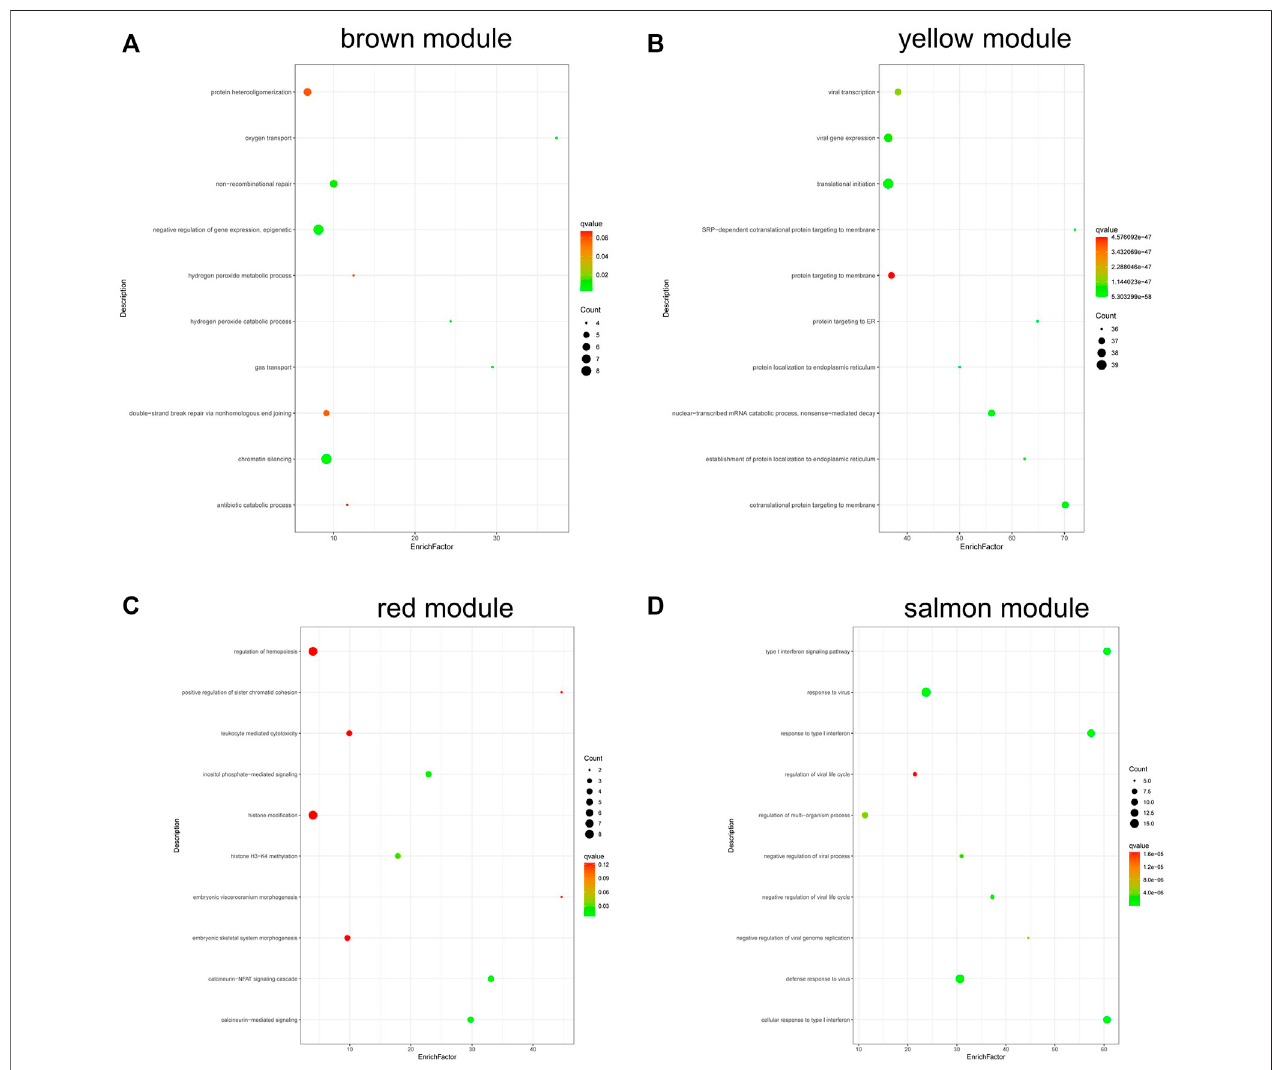
FIGURE 7 | GO analysis of genes in coexpression modules associated with relapsed GD. (A) Brown module; (B) Yellow module; (C) Red module; (D) Salmon module.